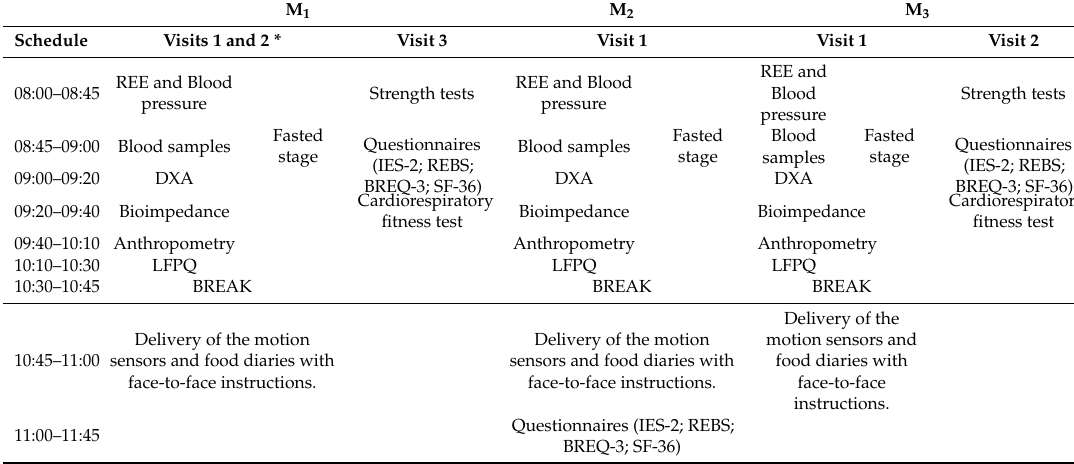
Table 1. Schematic description of all